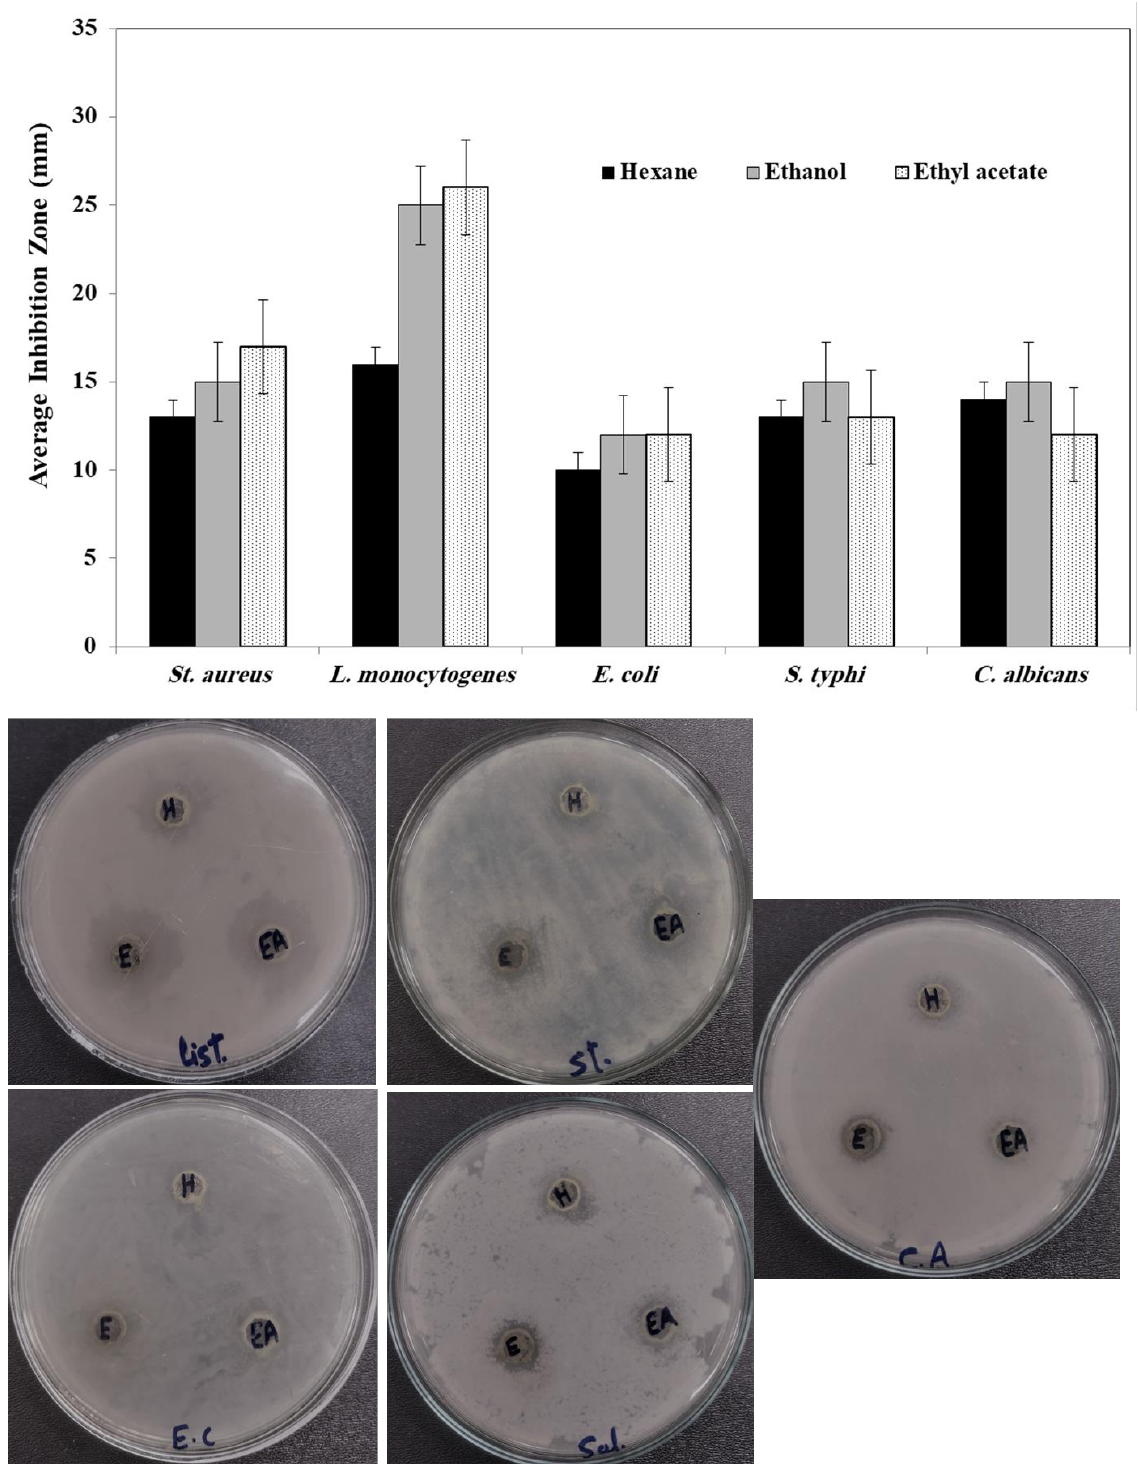
Figure 7. Antimicrobial properties of Echinops spinosissimus extracts at concentration of 100